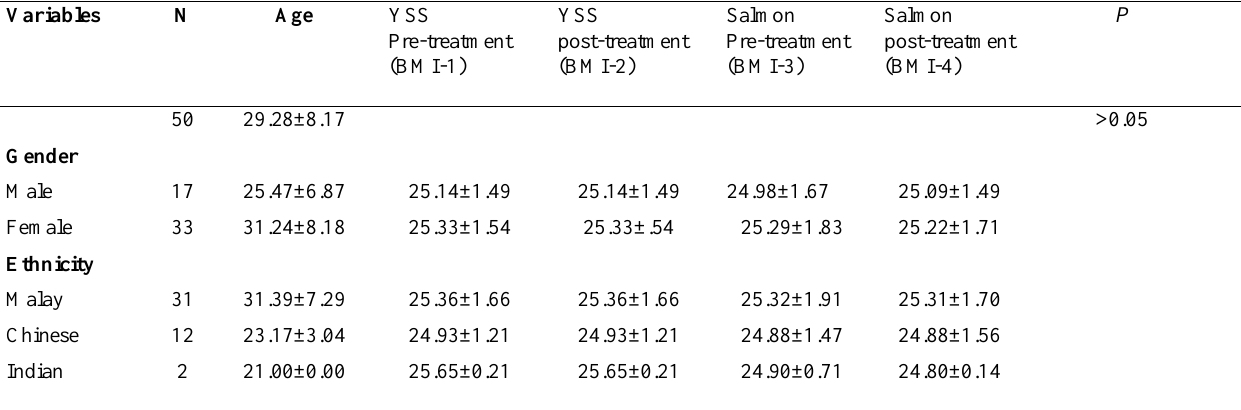
Table 1: Subjects’ sociodemographic data expressed as mean ± standard deviation